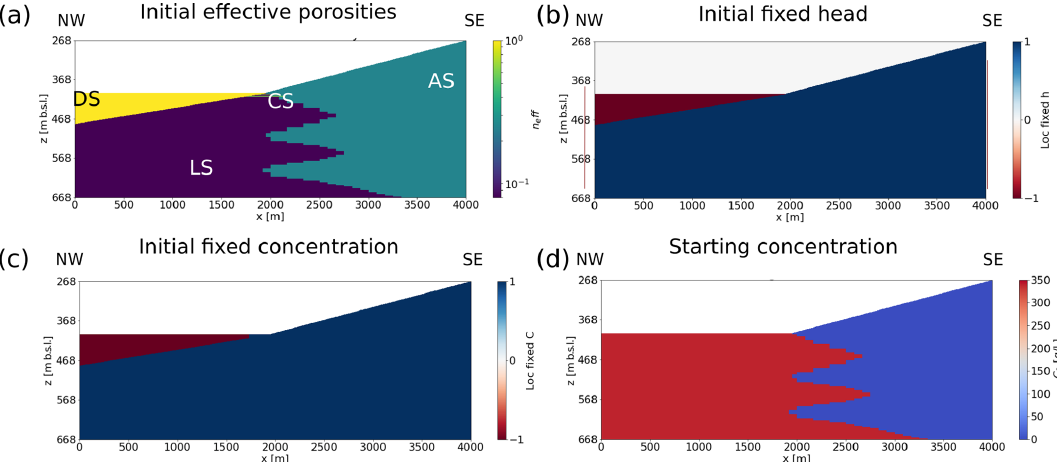
Figure B1. Hydrogeological model parameters. (a) Initial effective porosities for all materials. (b) Location of fixed head ( − 1), otherwise free head (1). Note that boundary conditions are also fixed but not visible due to the small cell width. (c) Initial location of fixed con- centration ( − 1), otherwise free concentration (1). At each channel mouth the DS concentration is set to free adjustment. (d) Initial salt concentration distribution. Dead Sea and lacustrine materials are valued by high values (340gL − 1 ), the alluvial sediments by low values (0.66gL − 1 ). LS stands for lacustrine sediments; AS are the alluvium sediments; DS is the Dead Sea and CS stands for the conduit system.